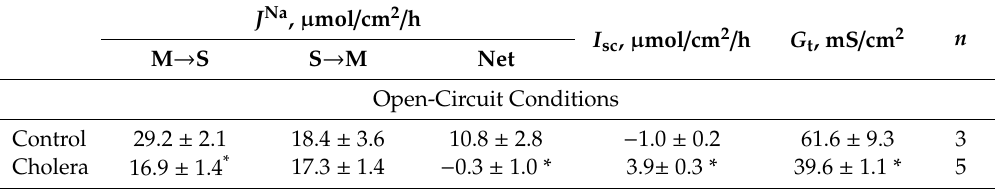
Table 3. Basal 22 Na + flux and electrical parameters in cholera toxin-diarrhea